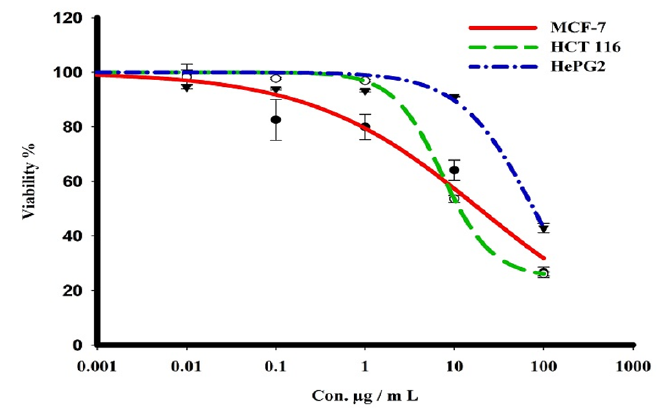
Figure 7. The dose–response curve of biosynthesized AgNPs from the cell supernatant of Streptomyces sp. ASM23 on the cytotoxicity in MCF-7, HePG2, and HCT 116 cell lines. Cells were exposed to biosynthesized AgNPs from the cell supernatant of Streptomyces sp. ASM23, with different concentrations of compounds for 72 h. Cell viability was detected by SRB stain.